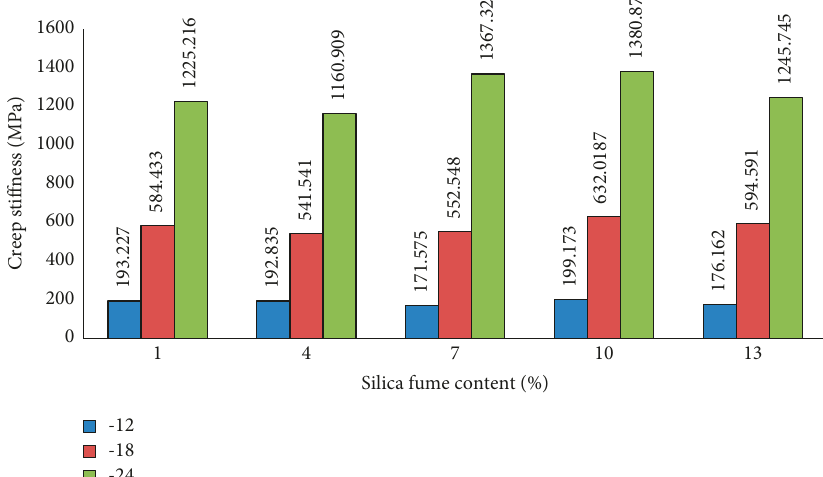
Figure 10: Influence of the content of silica fume on the creep stiffness.